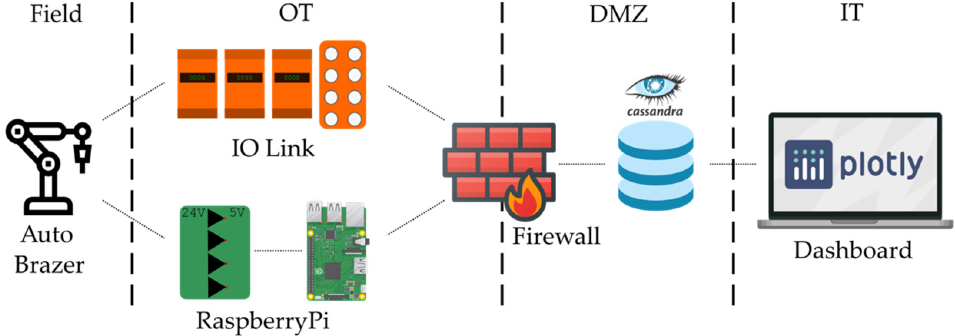
Figure 5. Data flow from Field Machine to End User. Demilitarised zone (DMZ).